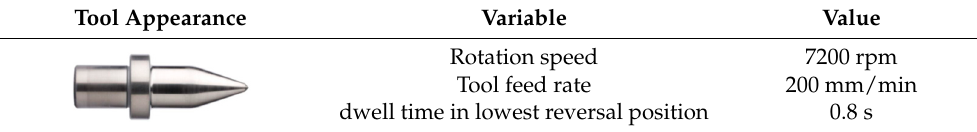
Table 5. Parameters of the drilling process.